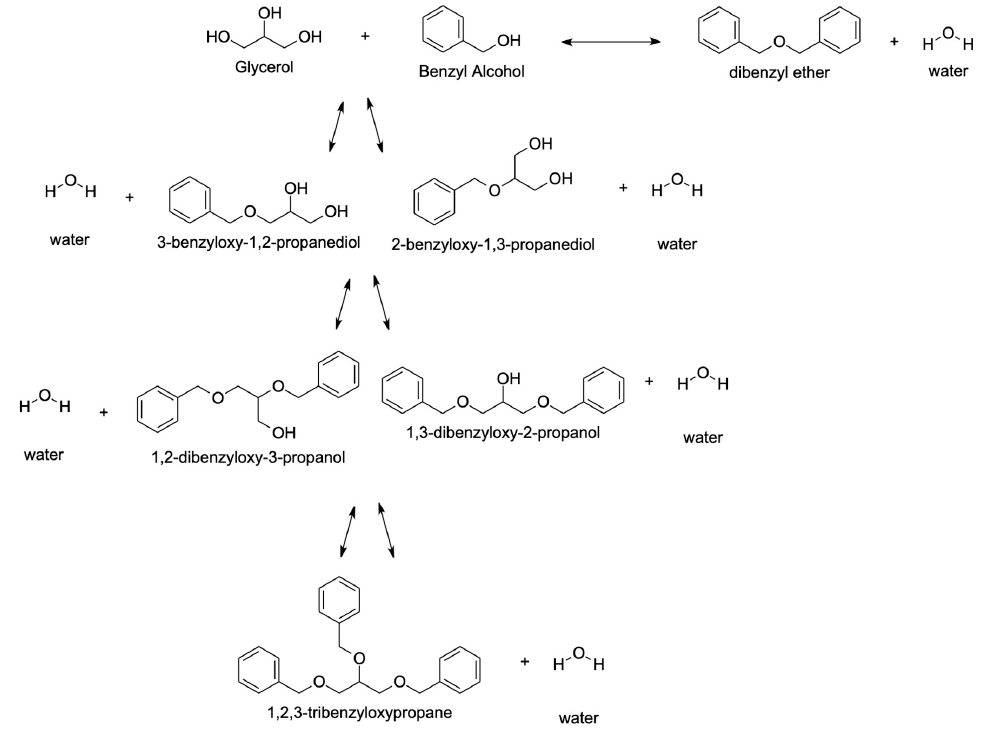
Figure 11. Reaction mechanism of glycerol etherification with benzyl alcohol [99].